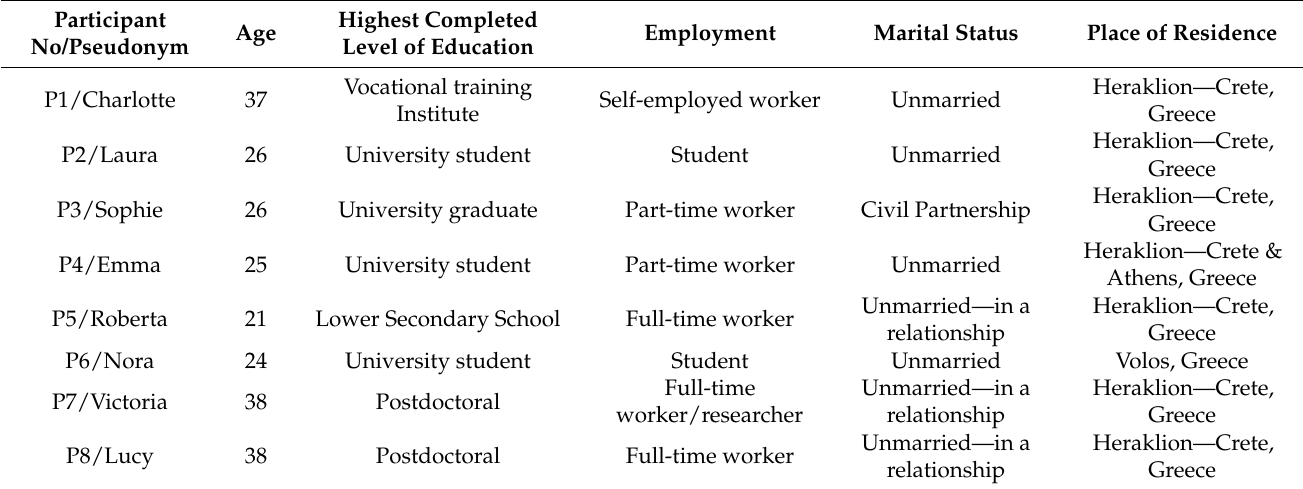
Table 1. Demographic characteristics of the